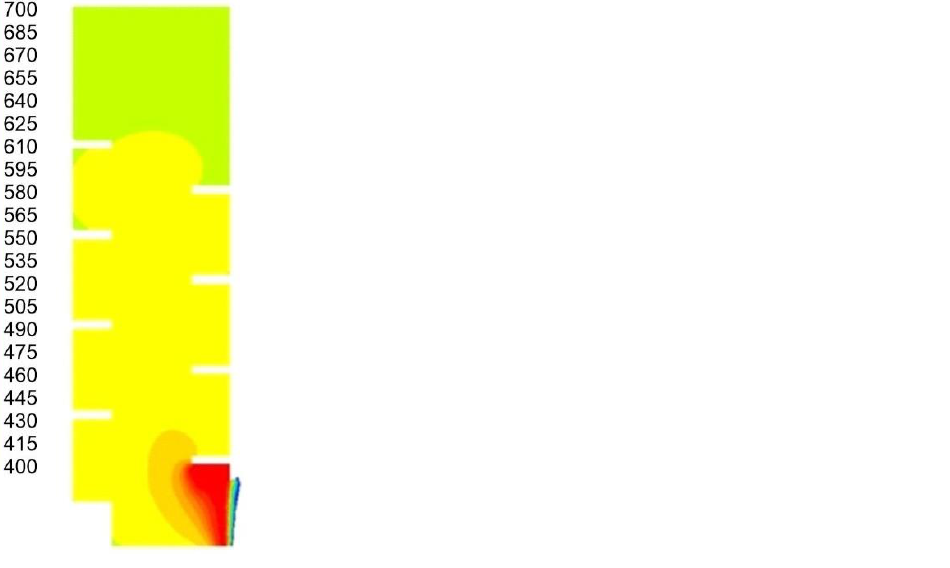
Figure 10. Temperature distribution after the window was opened. Temperature was measured in (K).